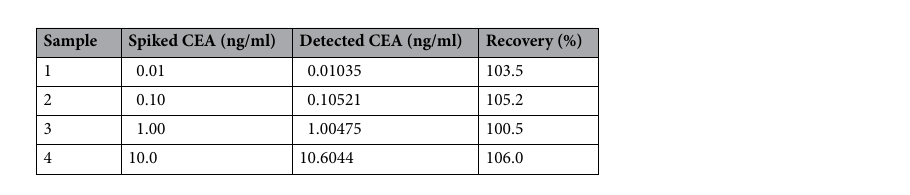
Table 3. Recovery test of CEA in human serum.